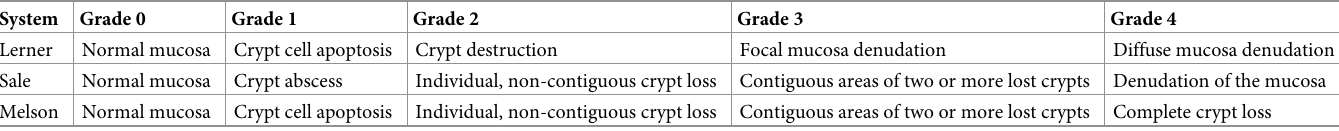
Table 2. The histologic grading systems for intestinal acute graft-versus-host disease used in this study. System Grade